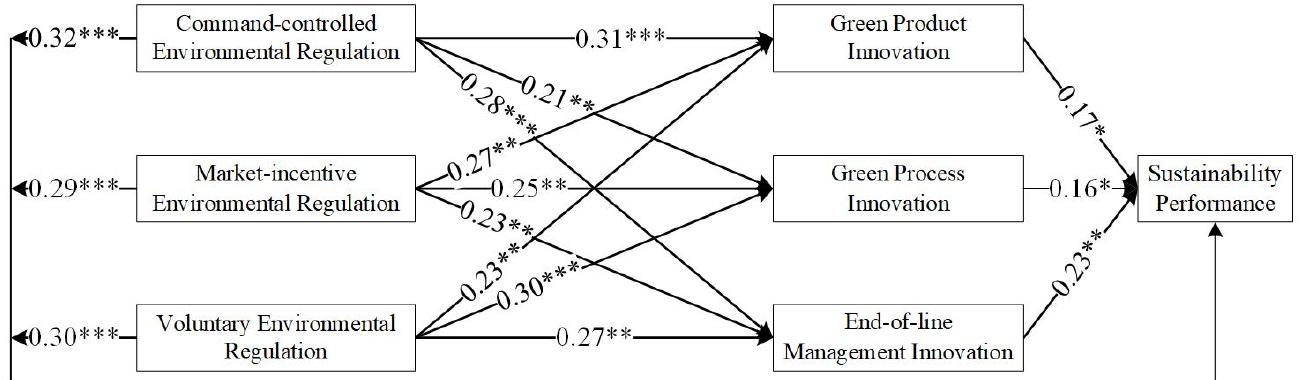
Figure 3. Results of the hypothesized model in East China. * denotes p < 0.05; ** denotes p < 0.01; *** denotes p < 0.001.